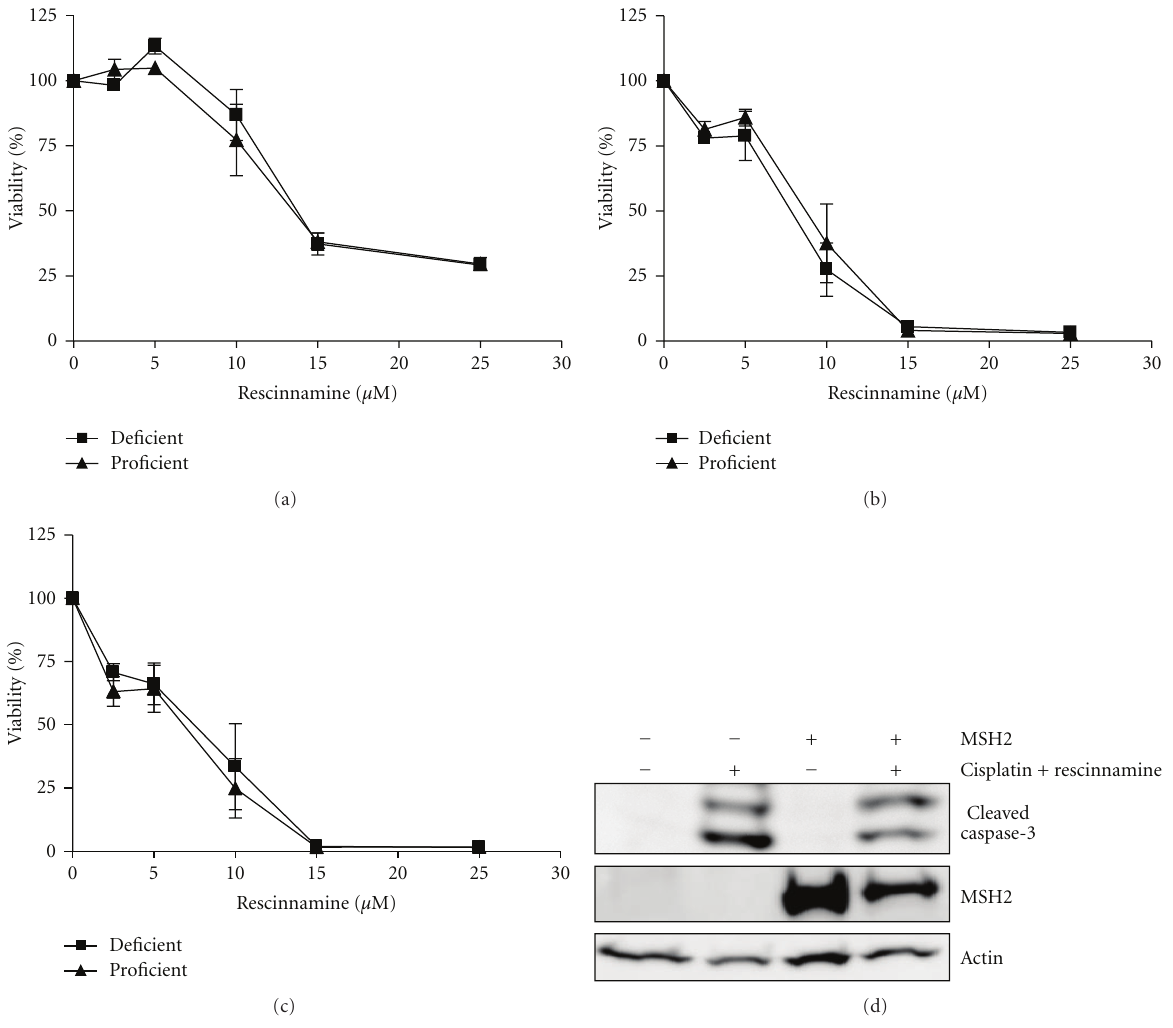
Figure 2: Combination treatment of cisplatin and rescinnamine drastically reduces cell viability within 24 hours (a) and completely eliminates all cells at 48 and 72 hours (b and c, resp.) when cells are treated with cisplatin (10 µ M) and increasing concentrations of rescinnamine (0–25 µ M). Cell viability is accessed via MTS assays; MSH2-deficient cells ( (cid:2) ) and MSH2-proficient ( (cid:3) ) cell response is shown. Mean values and standard deviations of three independent experiments are shown. (d) Immunoblotting demonstrates caspase-3 cleavage in Hec59 ( MSH2 -deficient; lanes 1 and 2) and Hec59(2) ( MSH2 -proficient; lanes 3 and 4) cells upon treatment with 24 hours of cisplatin (10 µ M) and rescinnamine (60 µ M). The 17 and 19kDa cleavage products of caspase-3 are depicted. Staurosporine (STS) was used as a positive control; actin was used as a loading